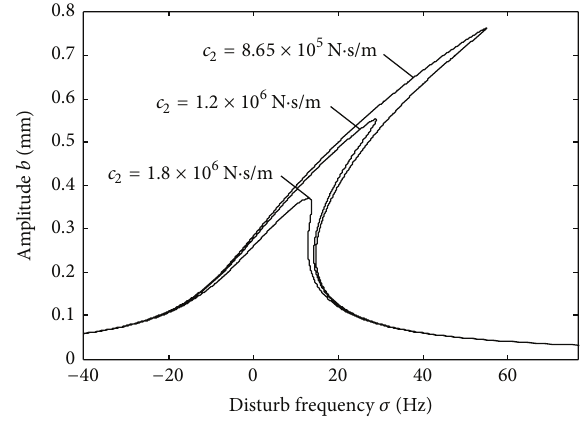
Figure 4: Main resonance amplitude-frequency curve of different nonlinear stiffness 𝑏 3 .